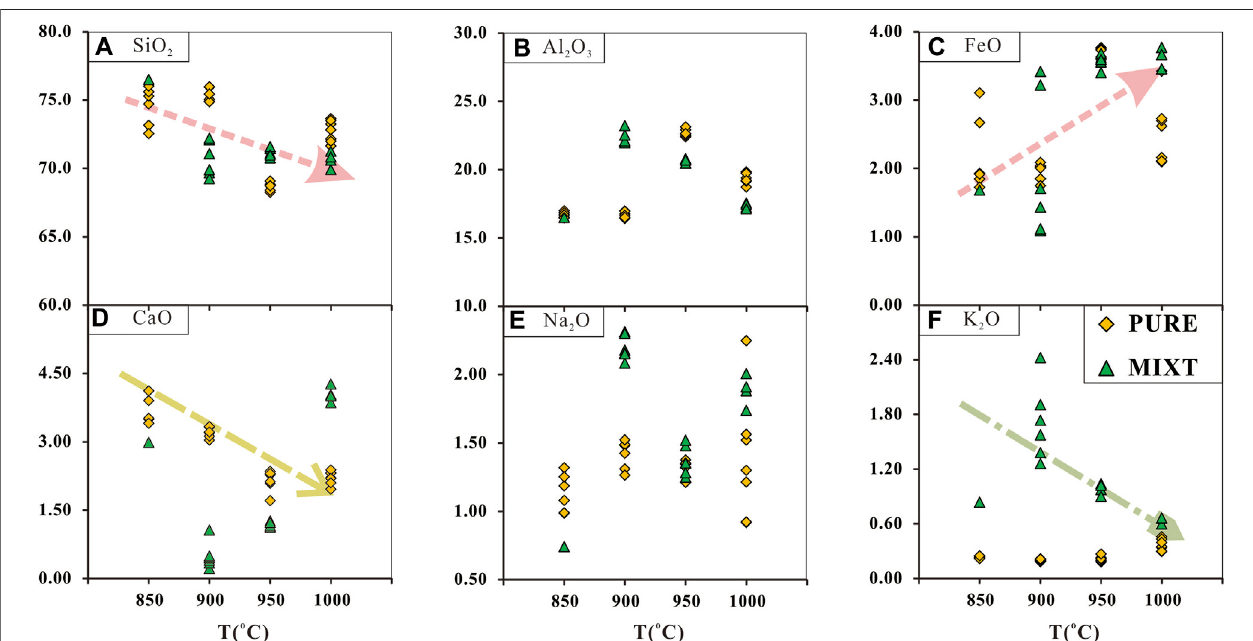
FIGURE 4 | Plots of major elements abundance of partial melts. PURE, melts generated from pure 18TH-02 (garnet plagioamphibolite, as the representative of metamorphicsubductedoceaniccrust);MIXT,meltsgeneratedfromamixtureof90 wt%18TH-02powerand10 wt%18TH-07(plagioclaseslate,astherepresentative of metamorphic subducted terrigenous sediments). All the quali fi ed original data of partial melts are shown in this fi gure; these data are listed in Supplementary Table S4 originalmajordata.Thepinkarrows markthevariationtrendofoxideabundance inpartialmeltsfromboth these twostartingmaterialsasthetemperature rose. The golden yellow arrow marks the variation trend of CaO in partial melts from PURE as thetemperature rose. The grass green arrow marksthe variation trend of K 2 O in partial melts from MITX as the temperature rose.